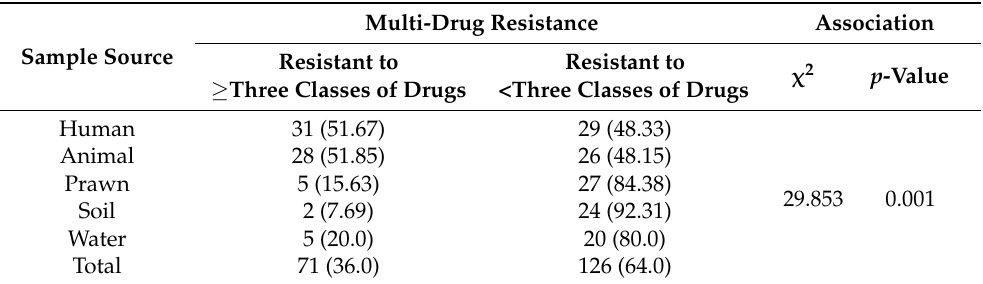
Table 3. Association of Multidrug-resistant E. coli with different sample